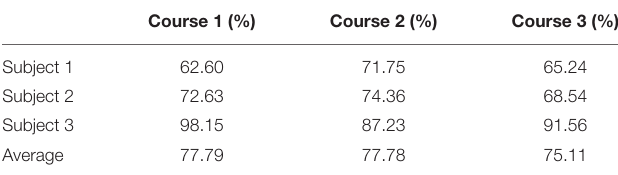
TABLE 1 | Comparison of attention ratio.